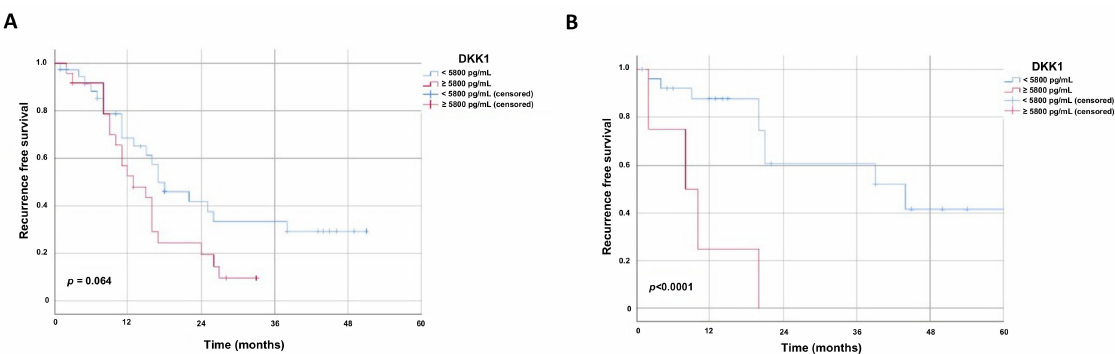
Figure 3. Kaplan–Meier survival curves displaying time to recurrence in esophageal carcinoma patients. Kaplan–Meier survival curves displaying time to recurrence in months within the ( A ) esophageal adenocarcinoma and ( B ) esophageal squamous cell cancer patients. Univariate analysis was carried out by the logrank test (Mantel–Cox). A p -value < 0.05 was considered as statistically significant. Patients who were lost during follow up were censored at their last documented visit. Time to recurrence of esophageal cancer patients with respect to S-DKK1 levels is displayed. Subgroups were built based on the mean values of all S-DKK1 levels in the 91 esophageal cancer patients (ESCC and